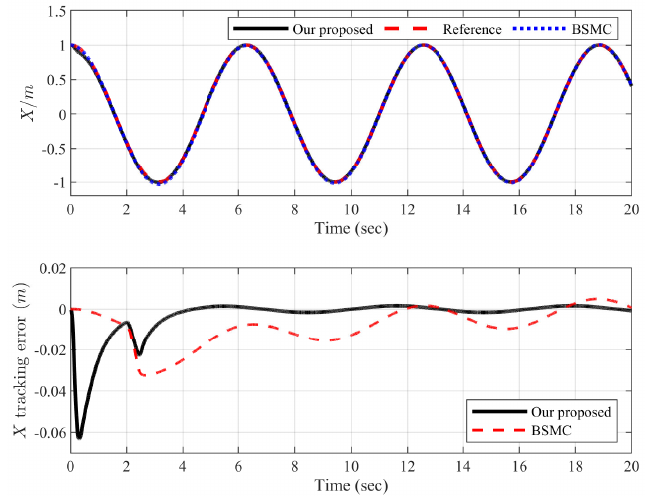
Figure 5. Diagram of the control performance in space.